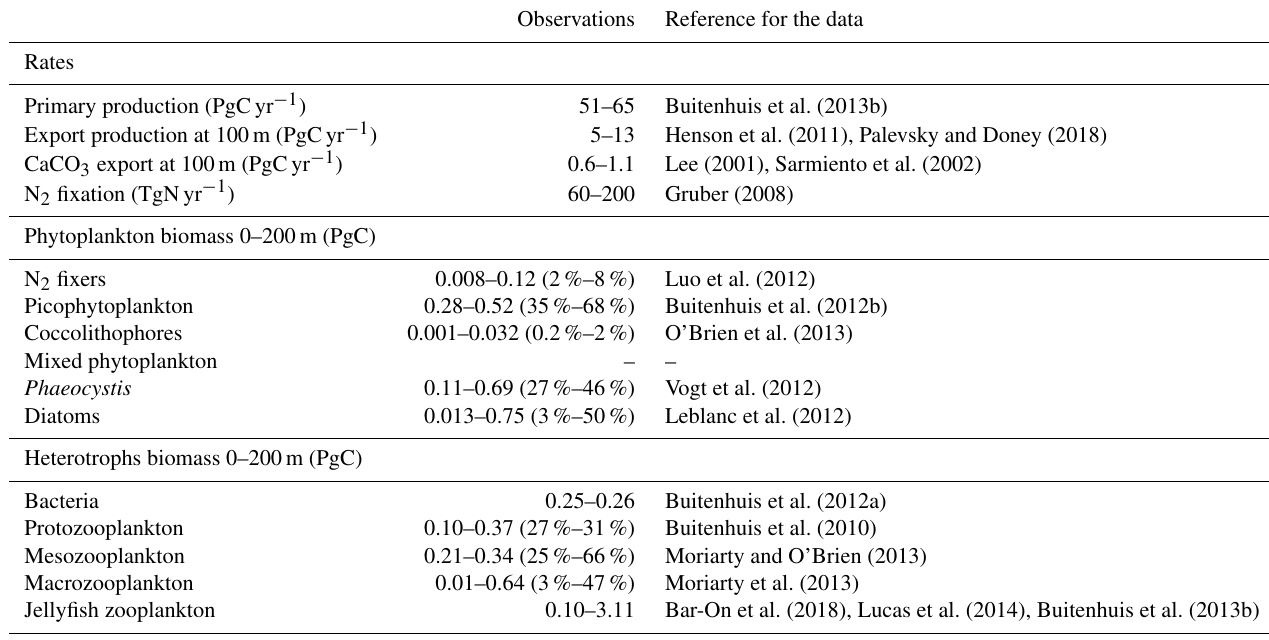
Table A5. Global mean values for rates and biomass from observations with the associated references. In parenthesis is the percentage share of the plankton type of the total phytoplankton or zooplankton